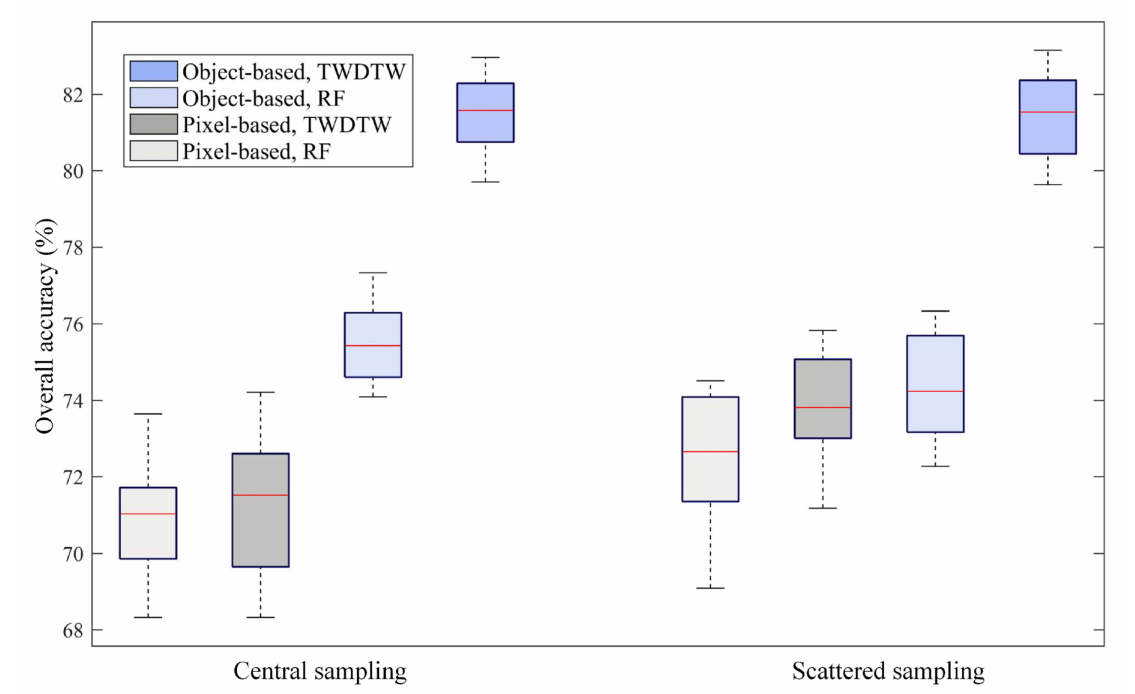
Figure 9. Box plots of 30-times overall accuracies for each classification strategy. Red line refers to the average accuracy. RF and TWDTW are the abbreviations of Random Forest and Time-Weighted Dynamic Time Warping, respectively.